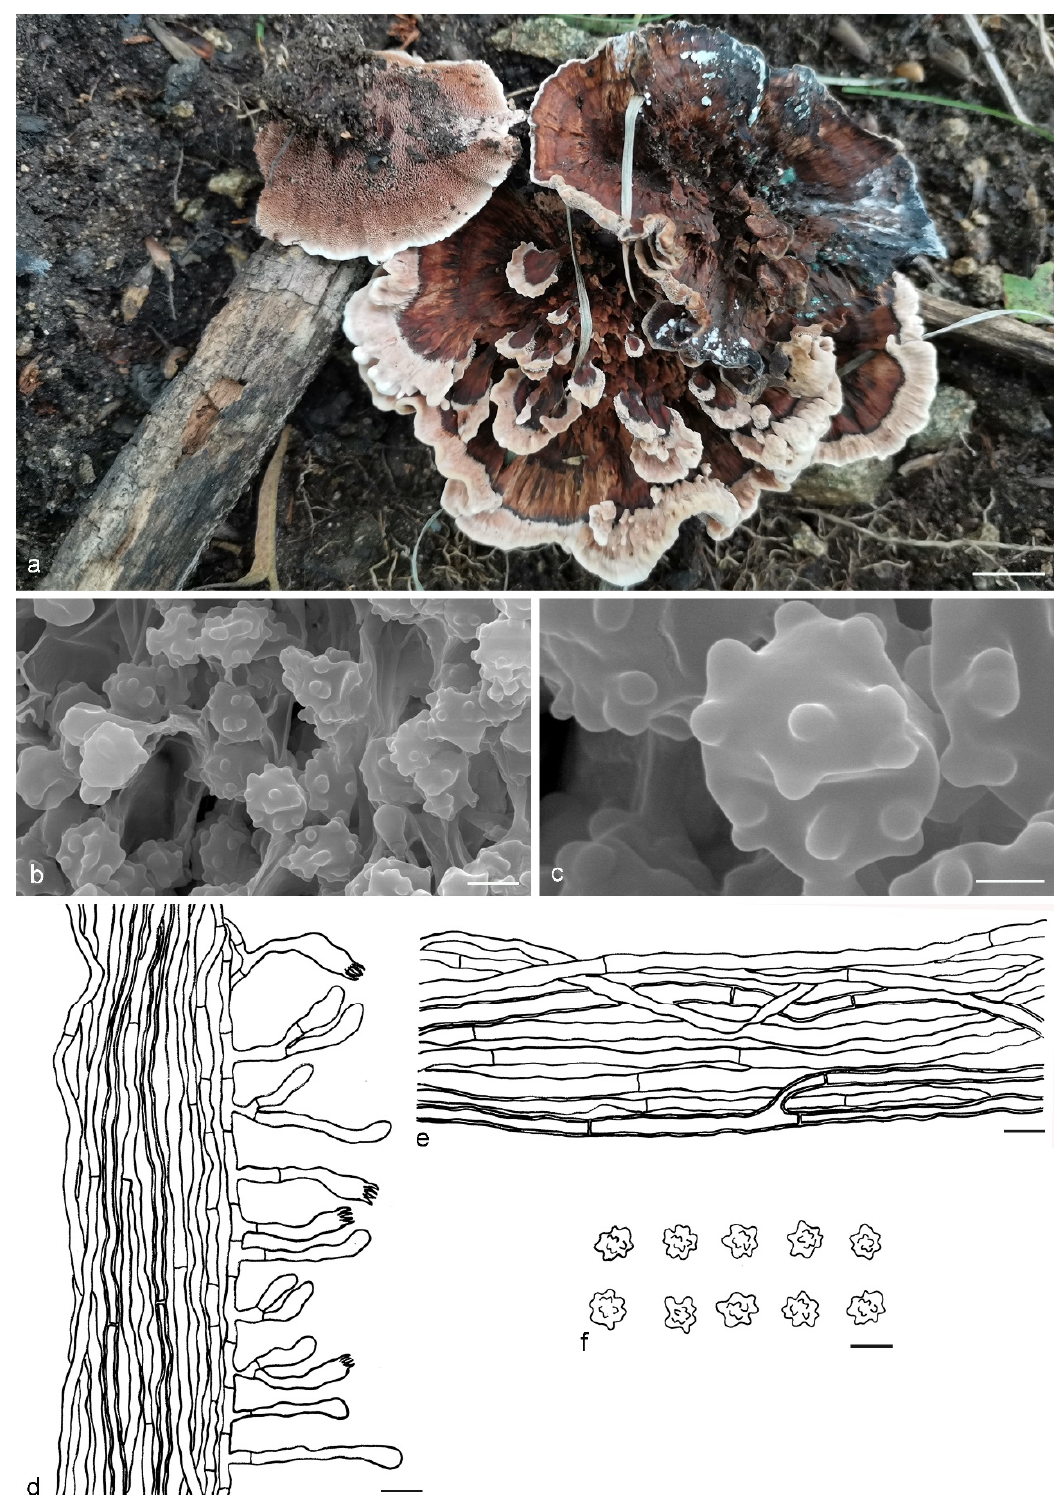
Figure 10. Hydnellum rubidofuscum. ( a ): Basidiocarps; ( b , c ): SEM of basidiospores; ( d – f ): Microscopic structures (drawn from IFP 019408); ( d ): Section of hymenophore trama with basidia; ( e ): Hyphae from pileus context; ( f ): Basidiospores. Scale bars: ( a ) = 1 cm; ( b ) = 3 μm; ( c ) = 1 μm; ( d , e ) = 10 μm; ( f ) = 5 μm. Hydnellum squamulosum Y.H. Mu & H.S. Yuan, sp. nov. (Figure 11) MycoBank MB839042 Etymology . Squamulosum (Latin) refers to the minutely scaly pileal surface.